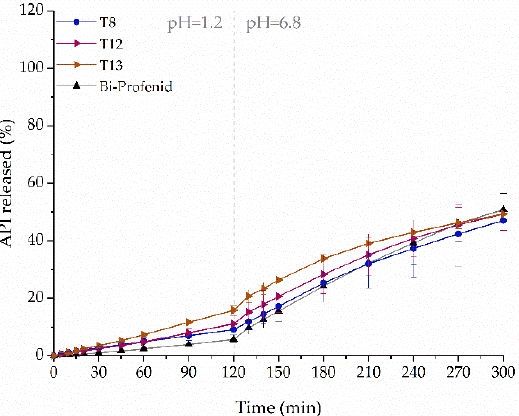
Figure 14. The dissolution profiles of ketoprofen from sustained-release formulations: Bi-Profenid and various 3DP tablets made from F3 filament (dosage equal to 150 mg).